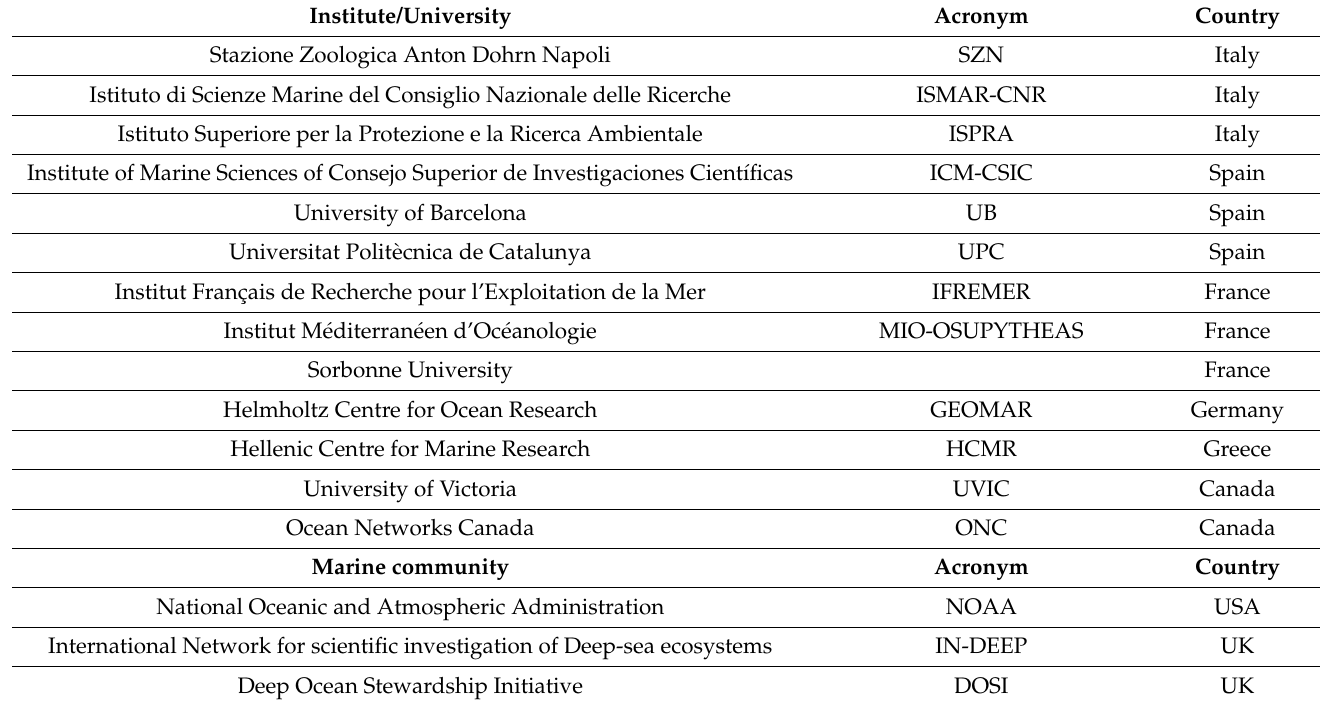
Table 1. Institutes, universities and marine communities contacted for Step 1